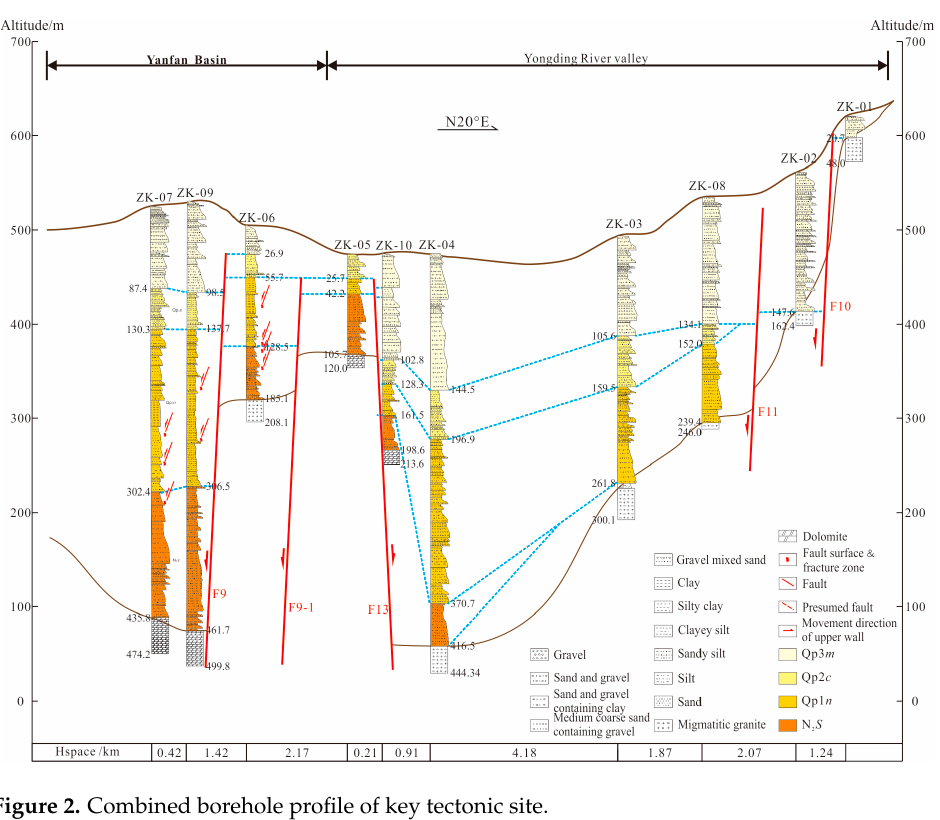
Figure 2. Combined borehole profile of key tectonic site.